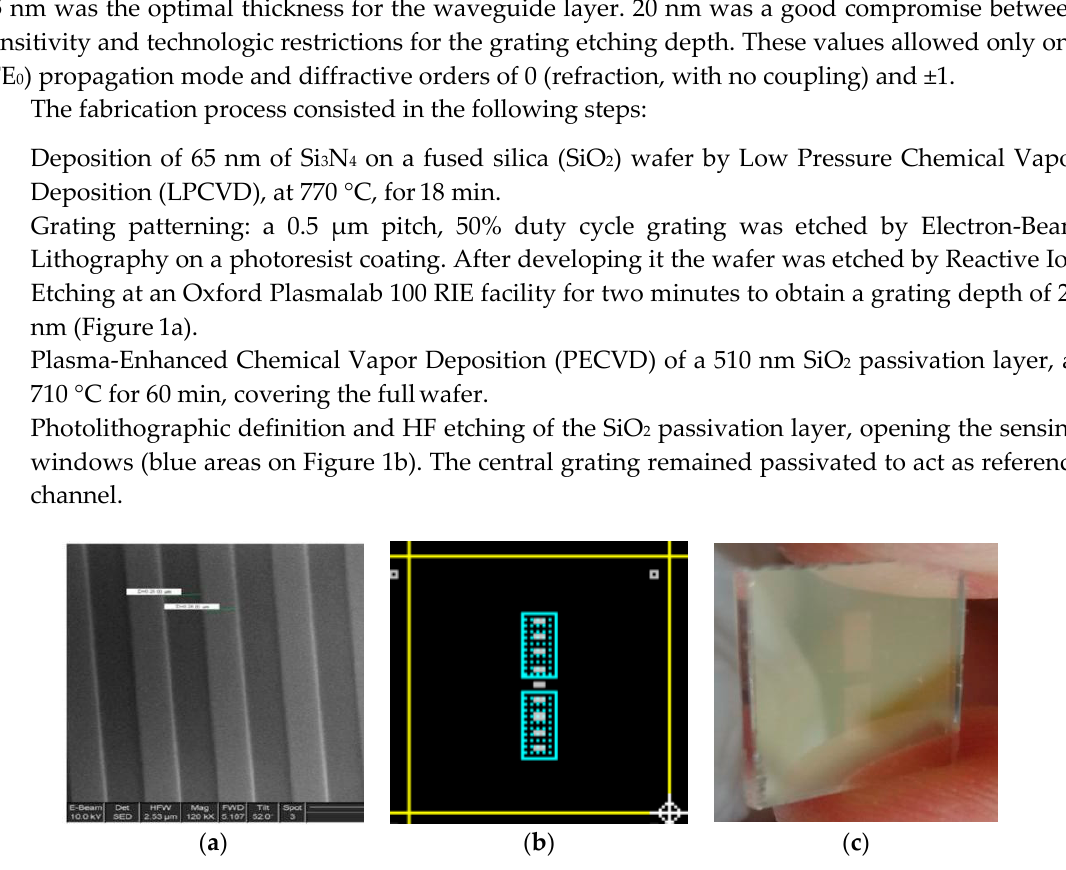
Figure 1. ( a ) SEM photograph of the fabricated diffraction grating with Λ = 0.5 µm; ( b ) Mask design of the nine-diffractive grating array. The blue rectangles correspond to the opening windows on the SiO 2 passivation layer; ( c ) Photograph of the fabricated grating sensor showing the top and bottom, sensing areas. In the middle, the reference grating remains